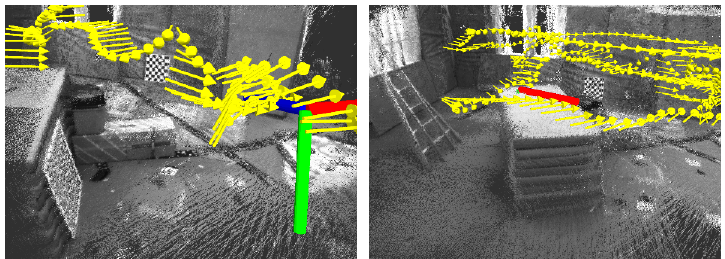
Figure 11. 3D environments reconstructed by our stereo VO for the EuRoC (European Robotics